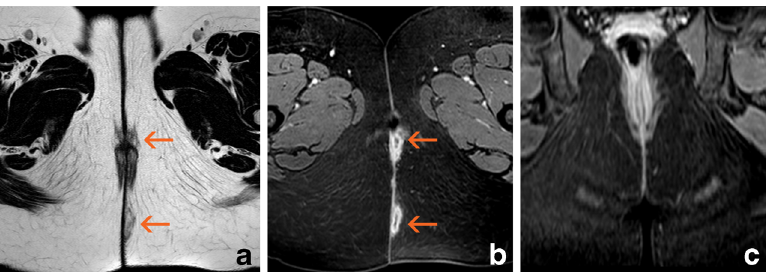
Fig. 4 Hidradenitis suppurativa. Skin and subcutaneous abscesses (arrows) are present in the anal cleft without anal involvement. a Oblique-transverse T2-weighted image. b Post-gadolinium oblique-